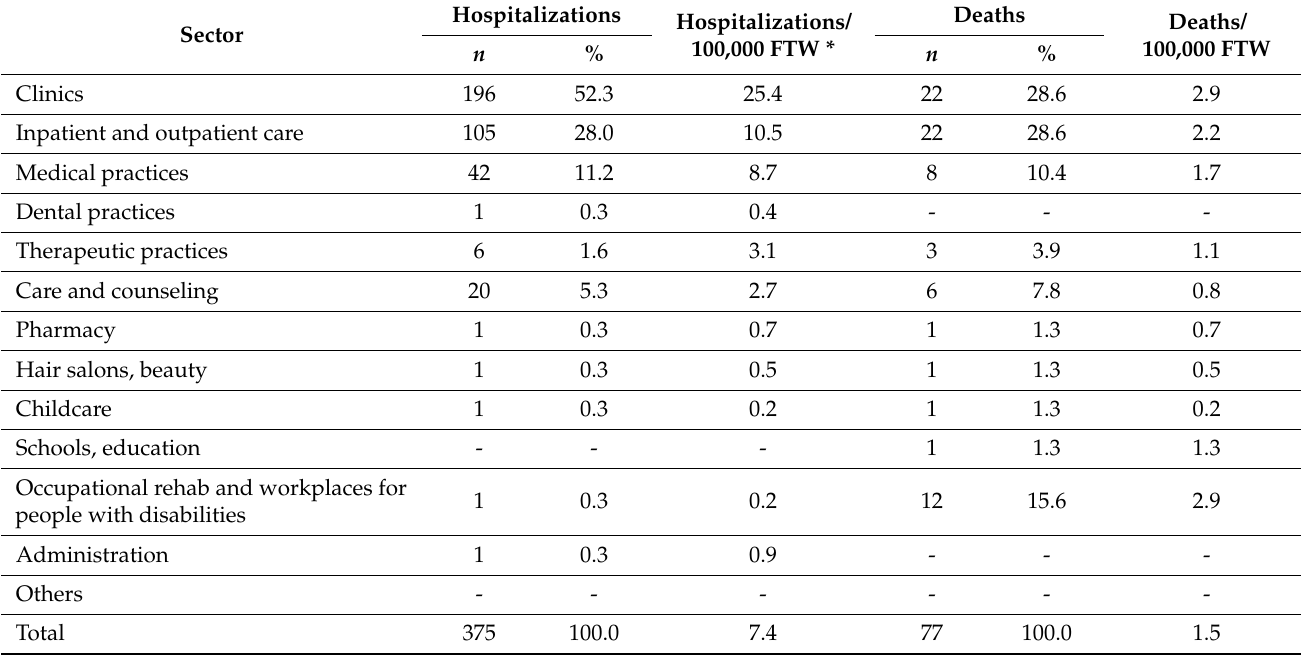
* FTW = full time workers.